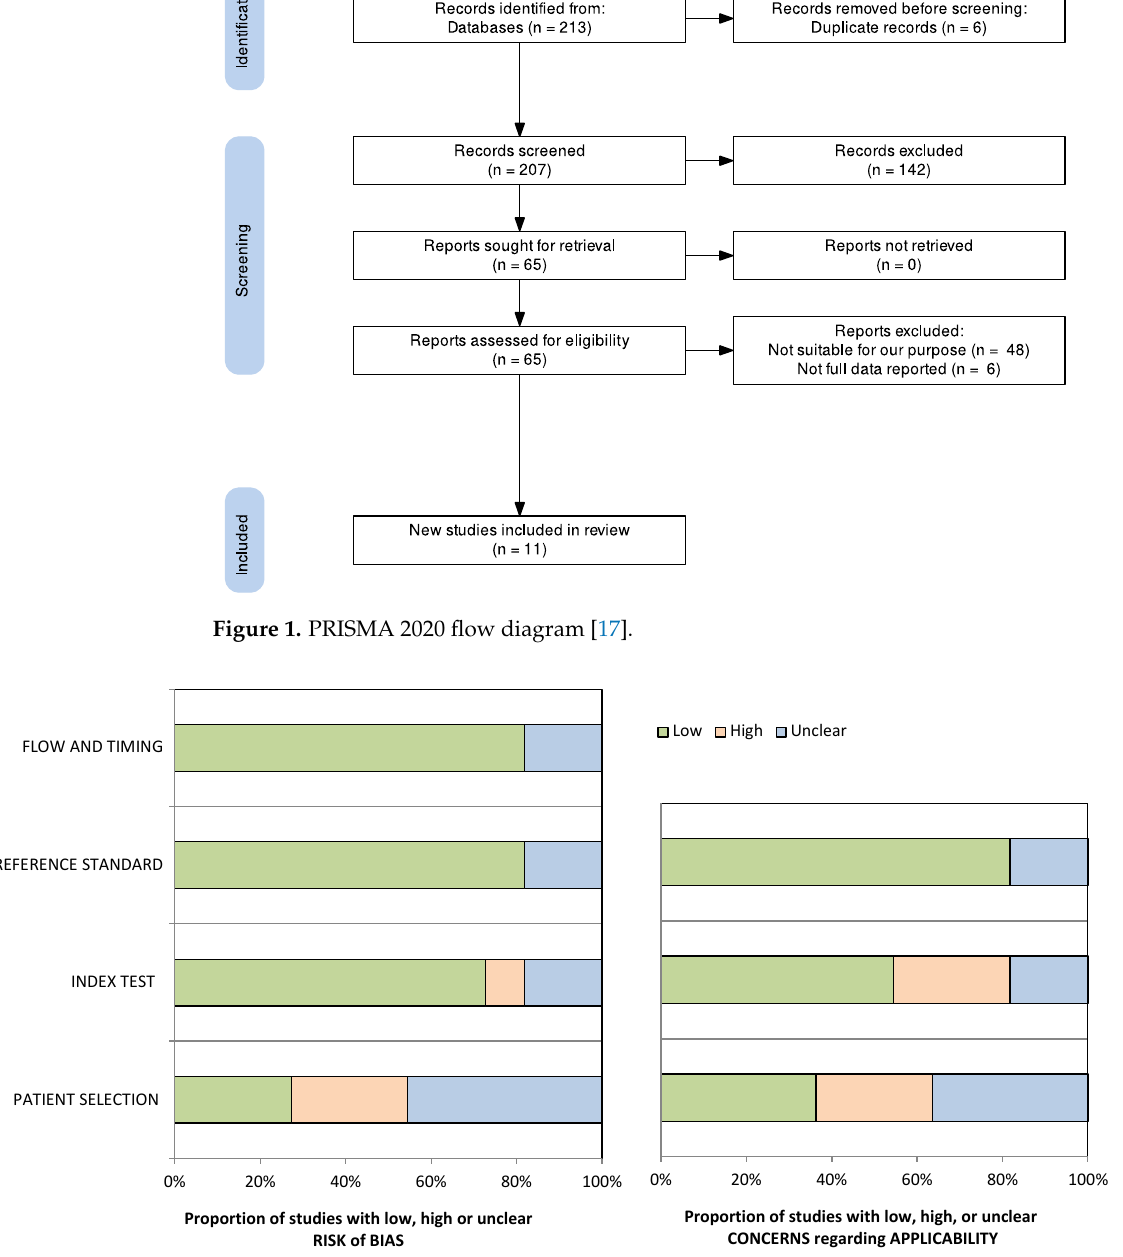
Figure 2. Quality Assessment of Diagnostic Accuracy Studies-2 Figure 2 . Quality Assessment of Diagnostic Accuracy Studies-2 (QUADAS-2) . Figure 2 . Quality Assessment of Diagnostic Accuracy Studies-2 (QUADAS-2) .